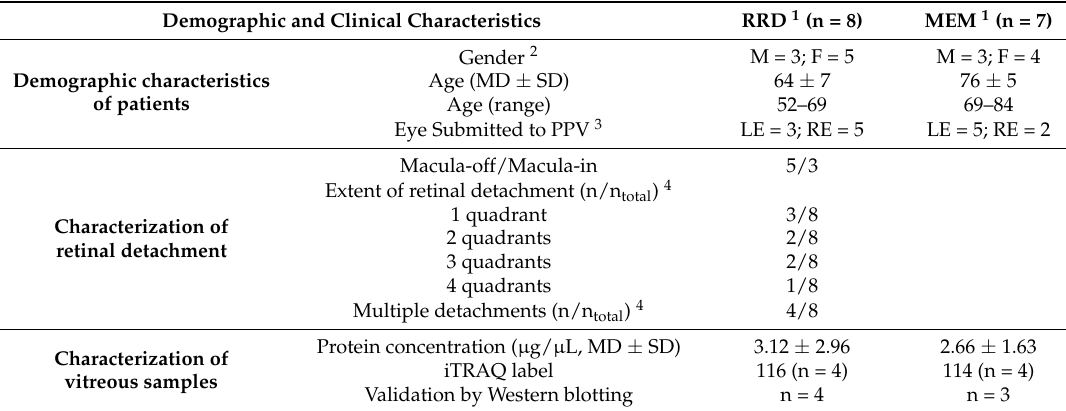
Table 1. Demographic and clinical characteristics of patients involved in the study and description of corresponding vitreous samples collected via pars plana